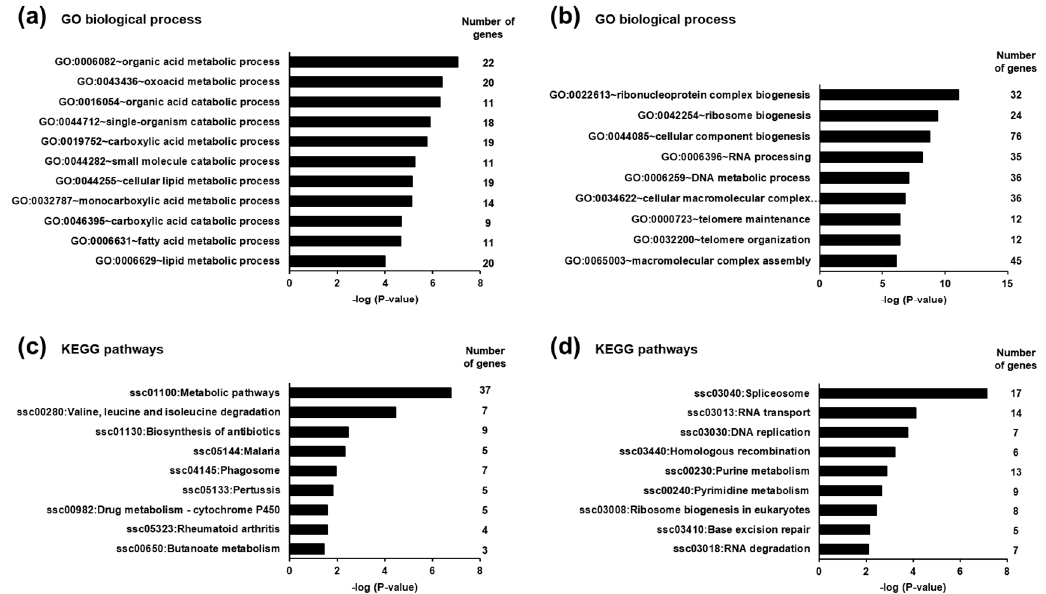
Figure 3. Most enriched gene ontology (GO) biological process terms ( a , b ) and KEGG pathways ( c , d ) associated with the genes up-regulated ( a , c ) and down-regulated ( b , d ) in suckling piglets between the SINS high group and the SINS low group. GO terms and KEGG pathways are sorted by their enrichment p -values (EASE score) (top: lowest p -value, bottom: highest p -value). ( a ): Only GO terms with p -values < 0.0001 are shown. ( b ): Only GO terms with p -values < 0.000001 are shown. ( c ): Only KEGG pathways with p -values < 0.05 are shown. ( d ): Only KEGG pathways with p -values < 0.01 are shown.